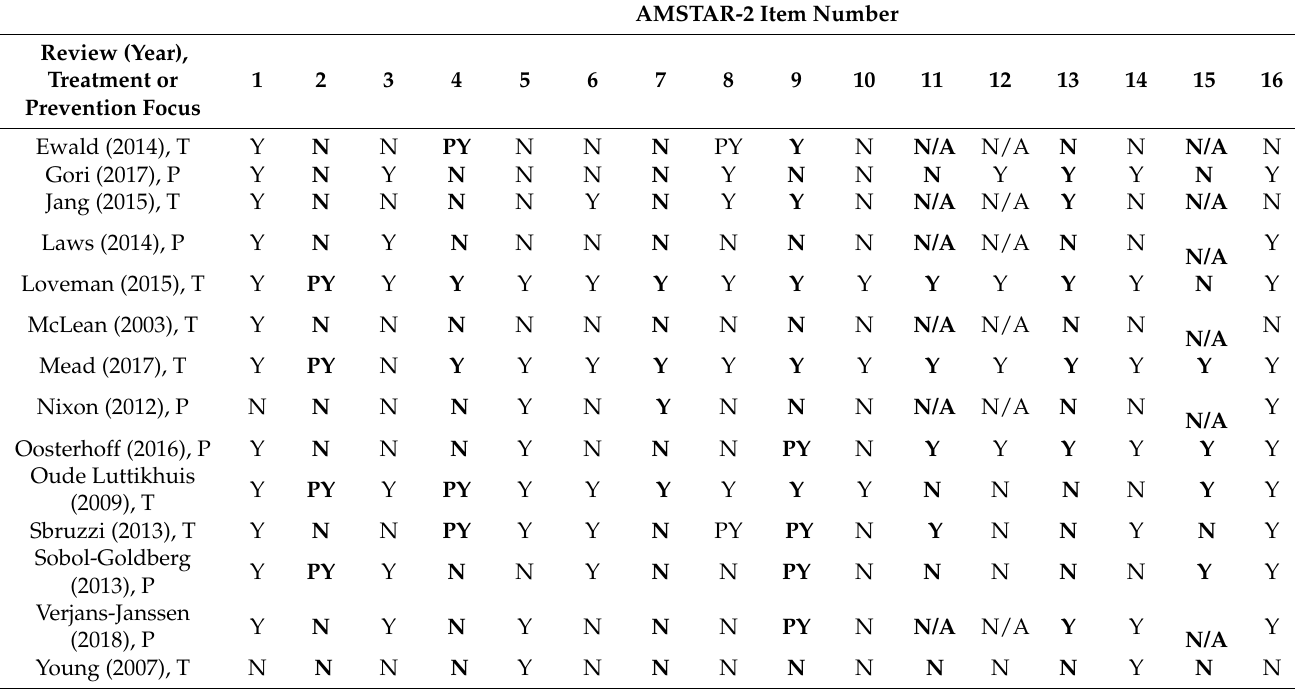
Table 2. AMSTAR-2 Assessment of Included Systematic Reviews and